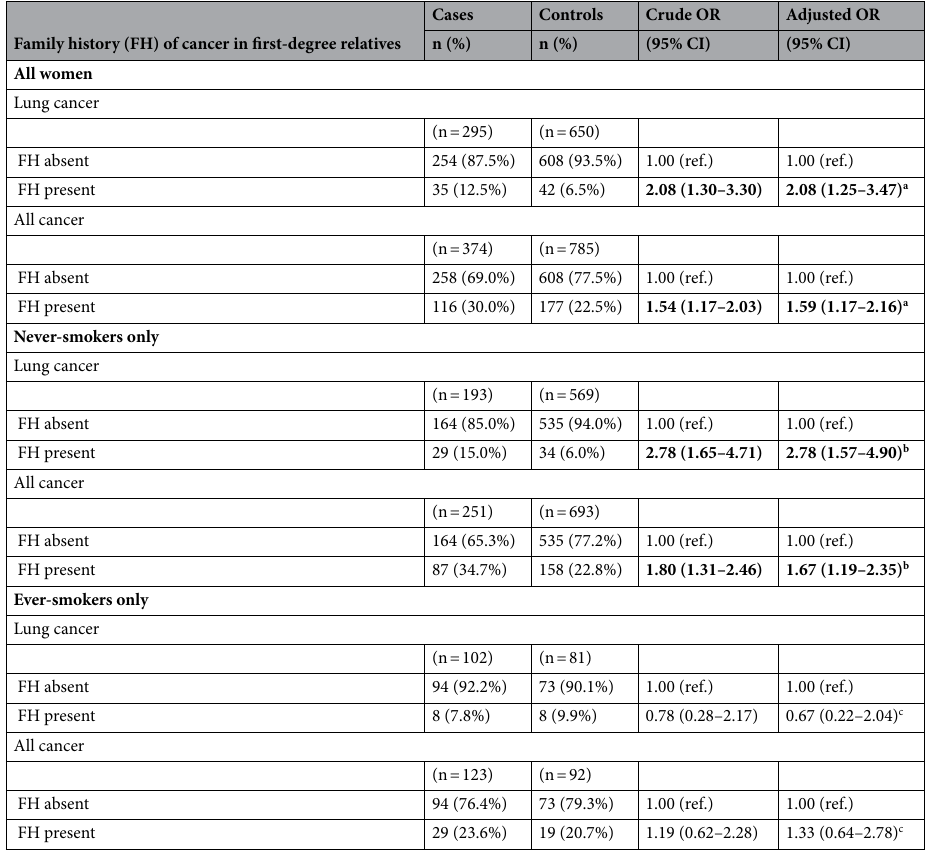
made up 77.2% of NSCLCs. Among the adenocarcinoma patients, the positive association remained among both the overall population (aOR 1.90, 95% CI 1.06–3.39) and never-smokers (aOR 2.39, 95% CI 1.26–4.51), as compared to those without family history of lung cancer. For non-adenocarcinoma NSCLC, small cell lung cancer and neuroendocrine carcinoma, a larger proportion of cases than controls reported a family history of lung cancer (Supplementary Table 2). Nonetheless, due to the small number of these cases with family history (fewer than 10), ORs were not calculated because of the limited power. The interaction effect between family history of any cancer and fruit consumption was statistically significant ( P = 0.021). The cutoff for low and high fruit consumption was determined by the median weekly servings of fruits among controls (7.36 servings/week). When stratified by fruit consumption level, both low and high fruit consumption groups who had family history of lung cancer were associated with a higher risk of lung cancer among the overall population (aOR 1.98, 95% CI 0.97–4.06 and aOR 2.24, 95% CI 1.05–4.77, respectively) and never-smokers (aOR 3.09, 95% CI 1.37–7.01 and aOR 2.58, 95% CI 1.14–5.84, respectively) (Table 3). Besides, there was a significant association observed for those who had family history of any cancer among the low fruit consumption group in the overall population (aOR 1.88, 95% CI 1.24–2.86). Restricting to never-smokers only, this association was still significant (aOR 1.99, 95% CI 1.24–3.19).